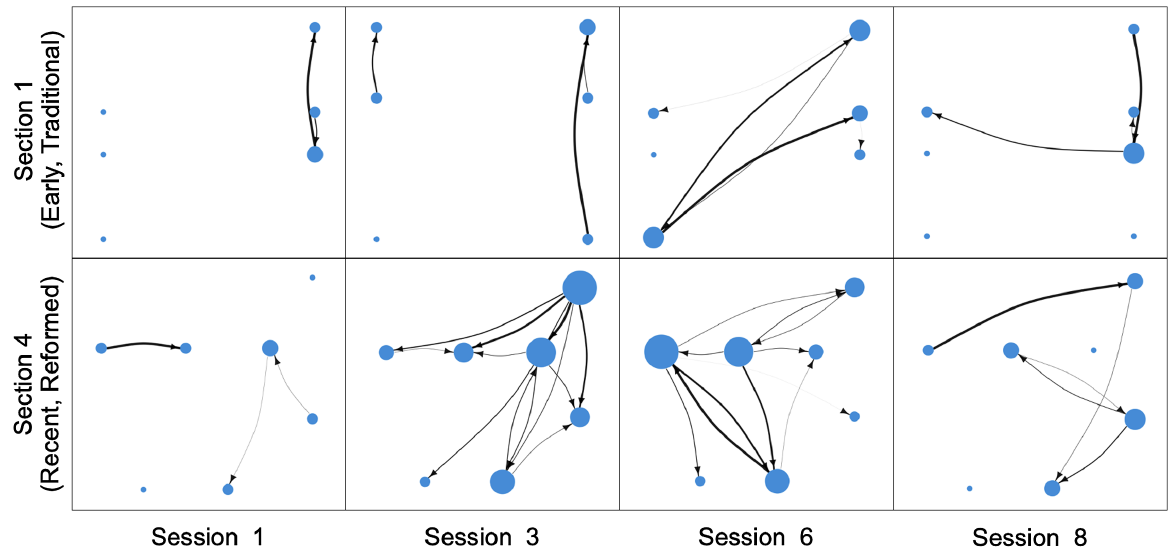
FIG. 2. Sample network diagrams for four sessions of lab sections 1 and 4 produced from our video coding. Each node represents a lab group and nodes are positioned according to the actual table layout of the classroom (Fig. 1). Node sizes are proportional to degree and are scaled the same for all diagrams. Edge thickness is proportional to strength, the sum of the time durations of interactions. Edge arrows point from the group that initiated the interaction to the responding